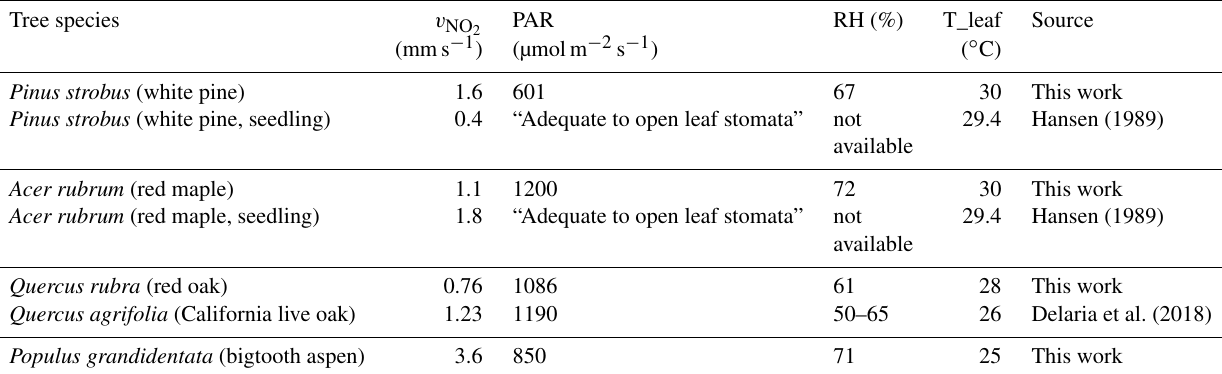
Table 3. Comparison of foliar NO 2 deposition velocity from this work and earlier studies. The maximum velocity measured in each enclosure is listed with the corresponding light, RH, and leaf temperature at the time of the measurement. Tree